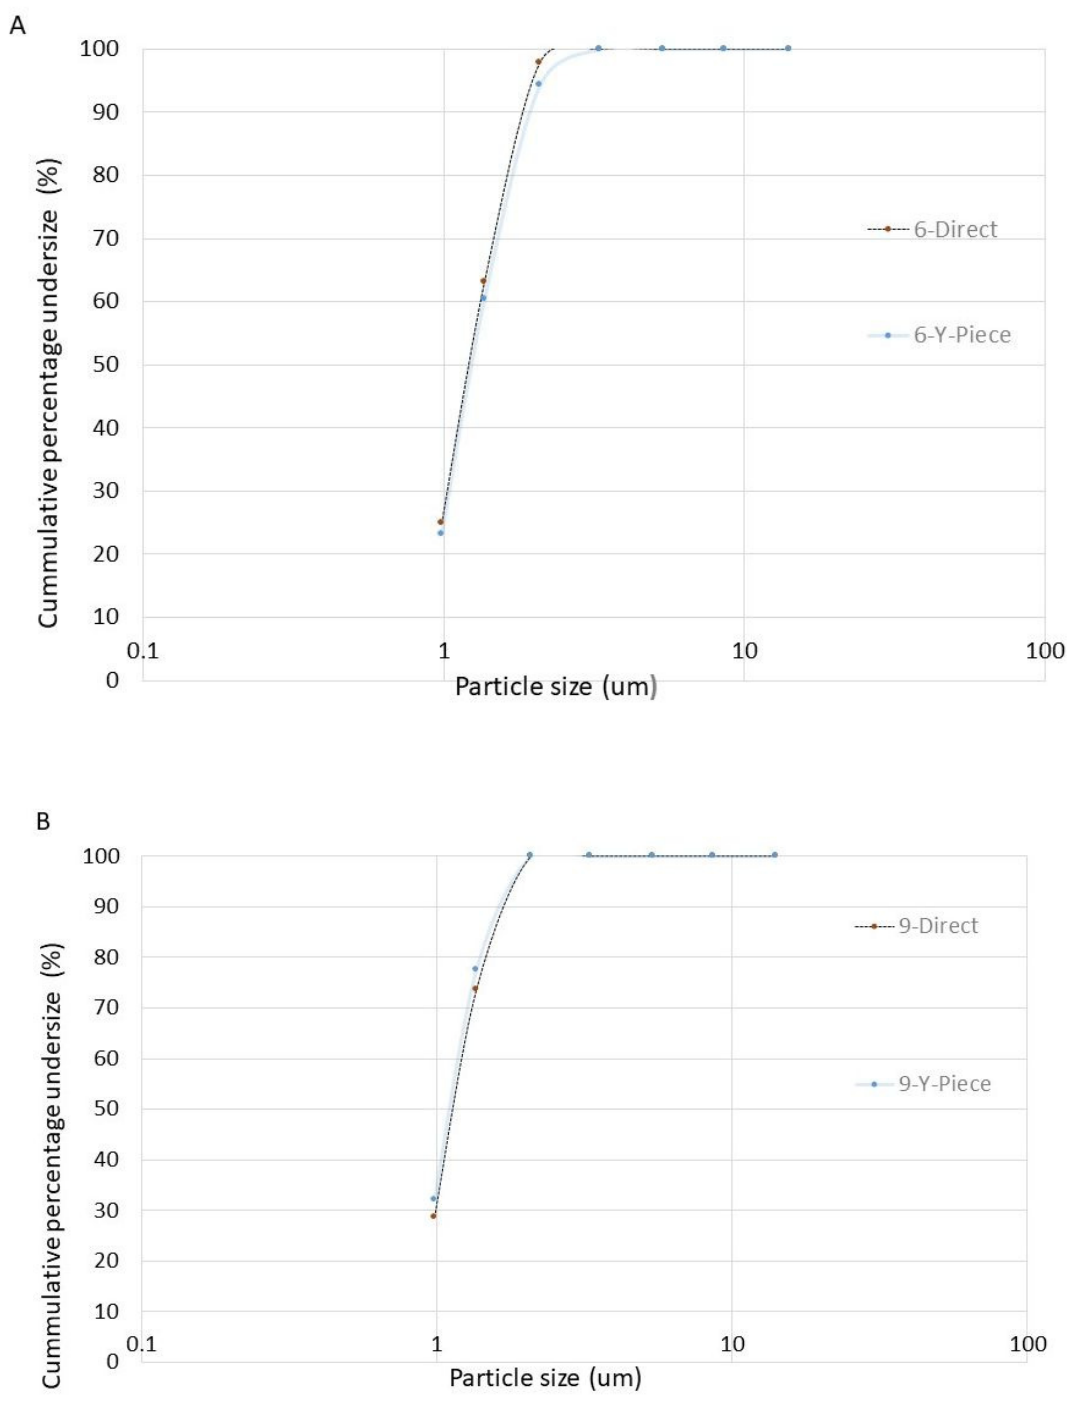
Figure 2. Plot of the logarithmic particle size against the cumulative percentage undersize for aerosols released by a large cannula when the nebulizer with Tee-piece was operated at 6 L/min (panel ( A )) and 9 L/min (panel ( B )) and connected to the humidifier directly or via Y-piece. Panel A = 6 L/min. Panel B = 9 L/min. 6-Direct = nebulizer operated at 6 L/min with the Tee-piece attached directly to the humidifier connected to circuit and large cannula. 6-Y-piece = nebulizer operated at 6 L/min with the Tee-piece attached to a Y-piece connected to the humidifier connected to circuit and large cannula. 9-Direct = nebulizer operated at 9 L/min with the Tee-piece attached directly to the humidifier connected to the circuit and large cannula. 9-Y-piece = nebulizer operated at 9 L/min with the Tee-piece attached to a Y-piece connected to the humidifier connected to circuit and large